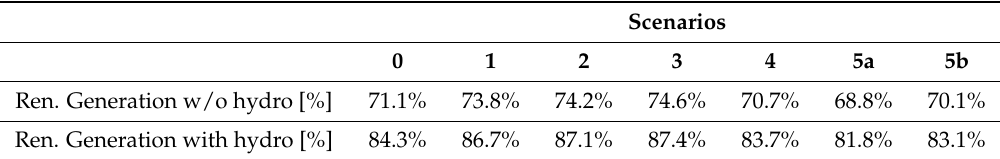
Table 10. Percentage of energy coming from renewable generation including and excluding hydro power stations in year 2050 for all the